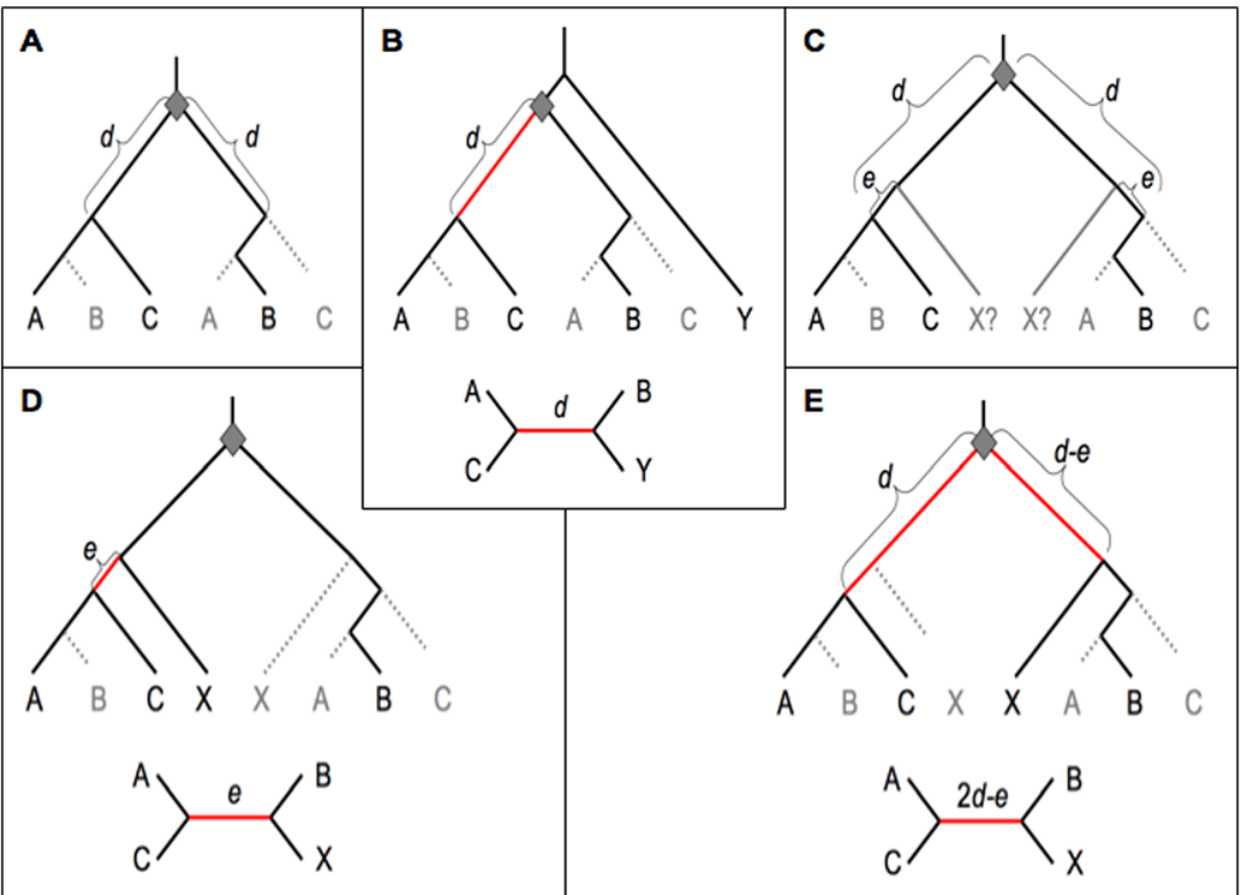
Figure 1. Differential loss of ancestral duplicates and gene trees with single outgroups, for different phylogenetic positions of the outgroup. a) The general case in which duplication (grey diamond) followed by differential gene loss (dotted grey lines) leads to a closer relationship between gene copies from species A and C, in contrast to the species relationship. b) The case for a single pre-duplication outgroup Y. c) The general case for a post-duplication outgroup X diverged time e before the C/AB split. d) X and C retain the same duplicate copy. e) X and B retain the same duplicate copy. Both rooted and unrooted trees are shown. Red branches indicate the NST internal branch, supporting an A + C group.